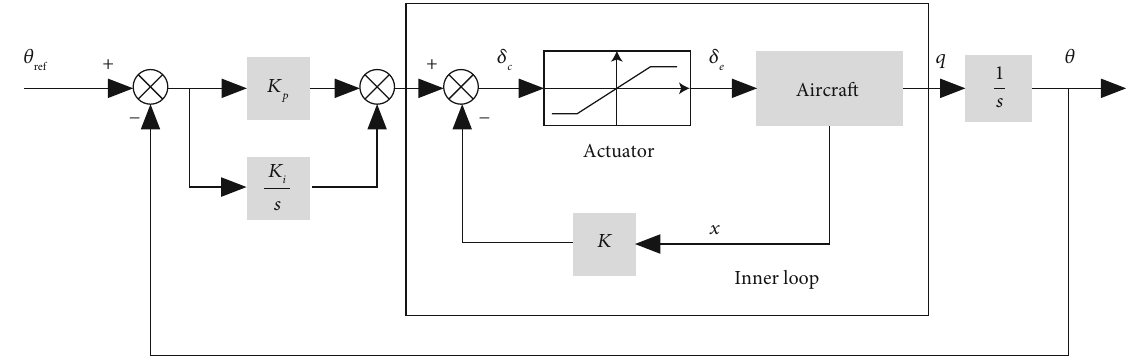
Figure 3: Inner-outer loop control